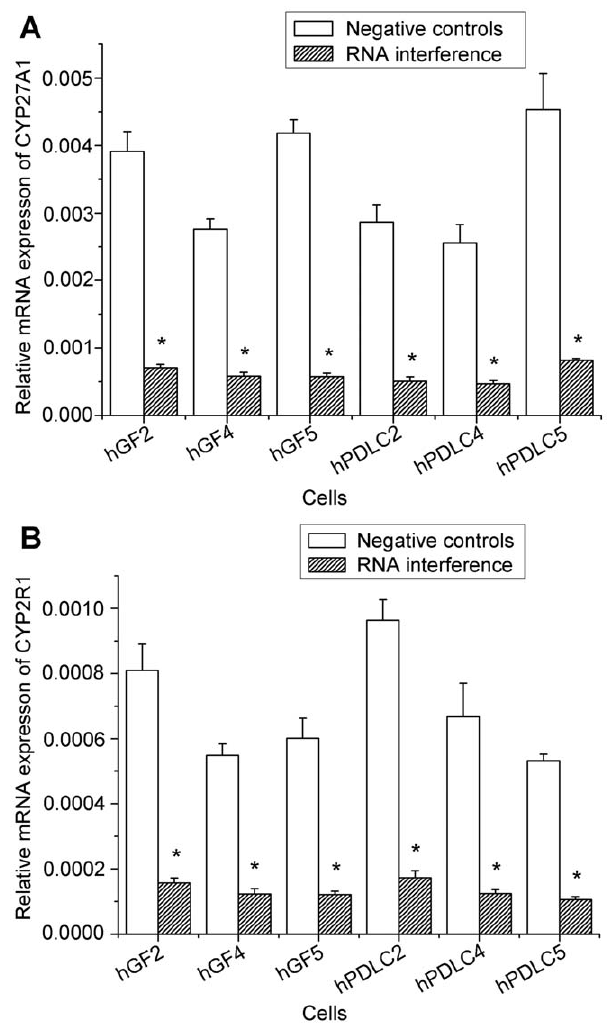
Figure 5. The efficiency of RNA interference against CYP27A1 and CYP2R1. hGF and hPDLC from donors 2, 4 and 5 were transfected with a siRNA oligonucleotide for CYP27B1, a siRNA oligonucleotide for CYP2R1, or a non-silencing control. Using real-time PCR as a measure, the efficiency of RNA interference against CYP27A1 and CYP2R1 was over 70% in hGF and hPDLC. The data are presented as the mean 6 SD. * denotes difference from negative controls ( p , 0.05).